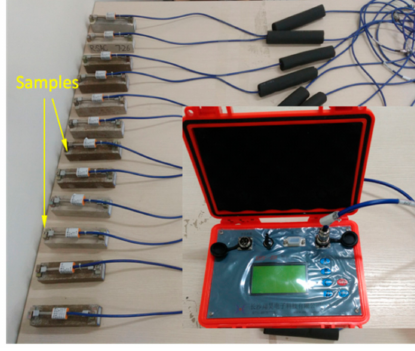
Figure 7. Device of length change test